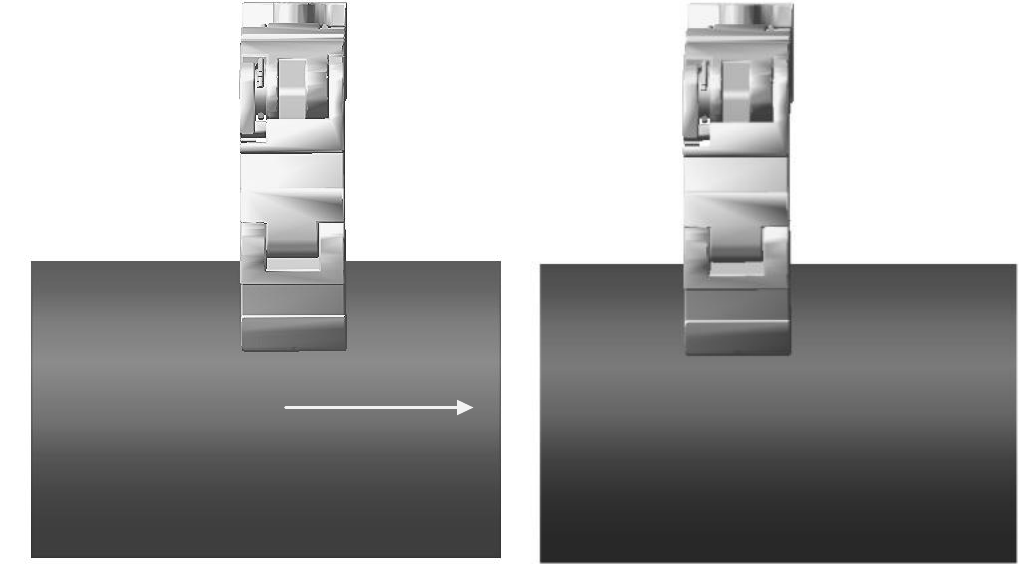
Figure 18. The finger makes contact with moving environment.